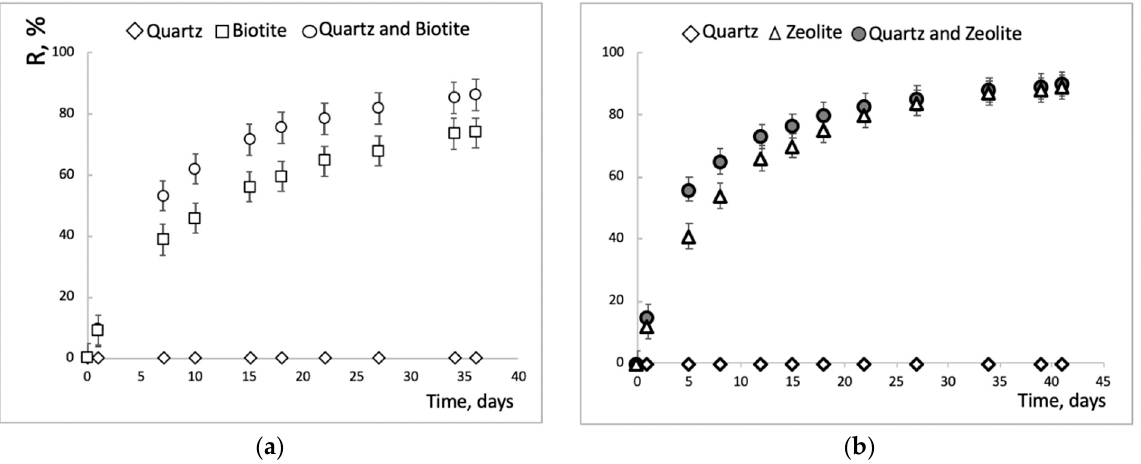
Figure 8. Kinetic of cesium sorption on crushed mineral phases ( a ) quartz, biotite phases in different containers (monomineral sorption), quartz and biotite in the same container (competitive sorption); ( b ) quart, zeolite NaA in different containers (monomineral sorption), quartz and zeolite NaA in the same container (competitive sorption).